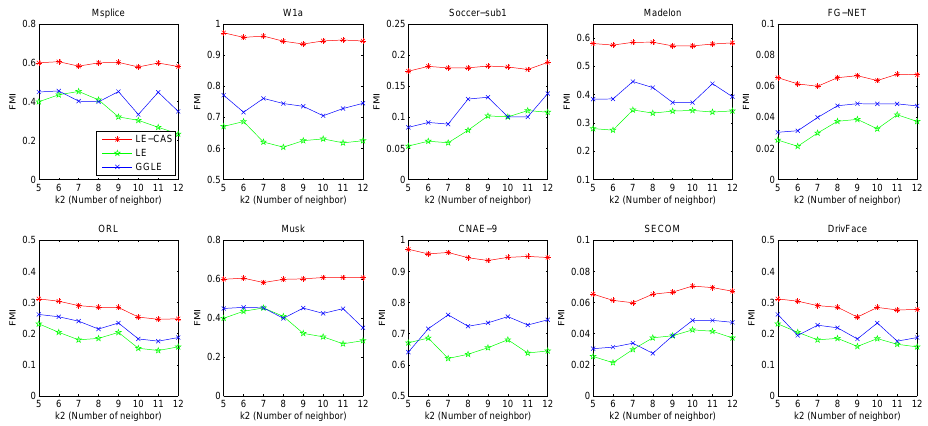
Figure 5. Results (FMI) vs. k 2 on ten datasets (Msplice, W1a, Soccer-sub1, Medelon, FG-NET, ORL, Musk, CNAE-9, SECOM, DrivFace).